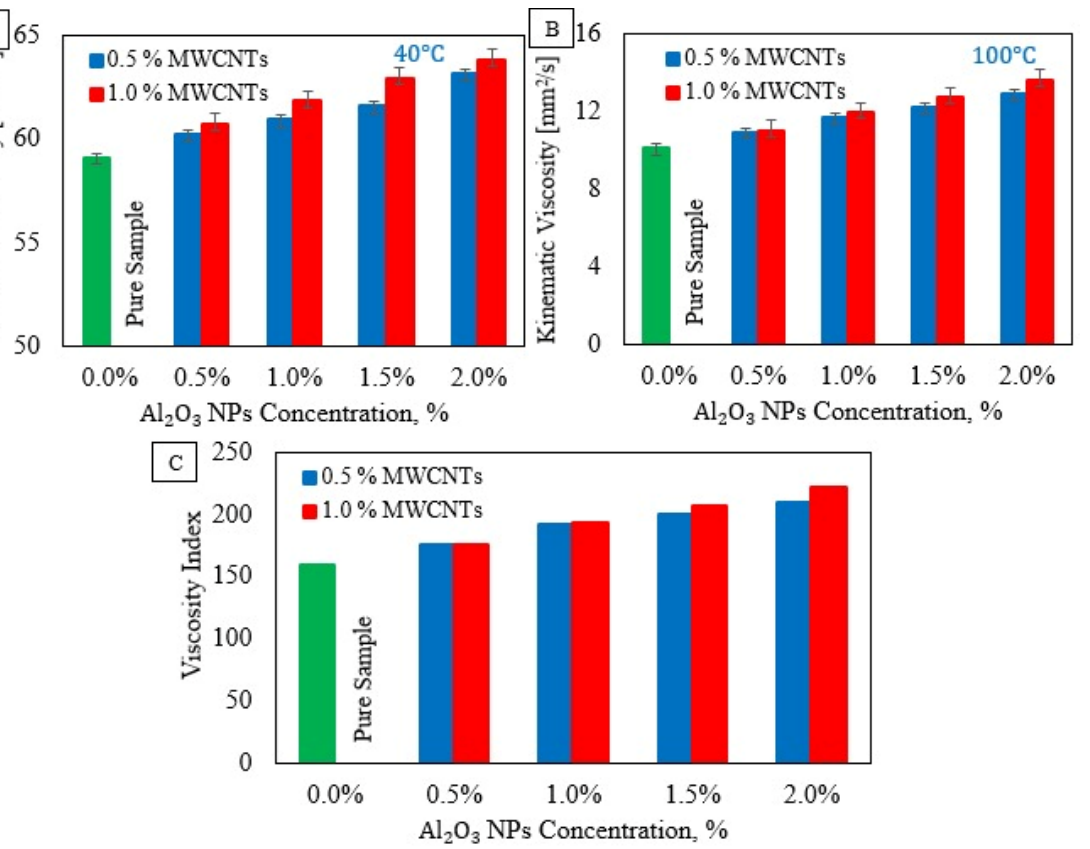
Figure 2. Kinematic viscosity of hybrid nano lubricant samples at temperatures of ( A ) 40 °C ( B ) and 100 °C. ( C ) Viscosity index of hybrid nano lubricant samples with 0.5 and 1% MWCNTs.